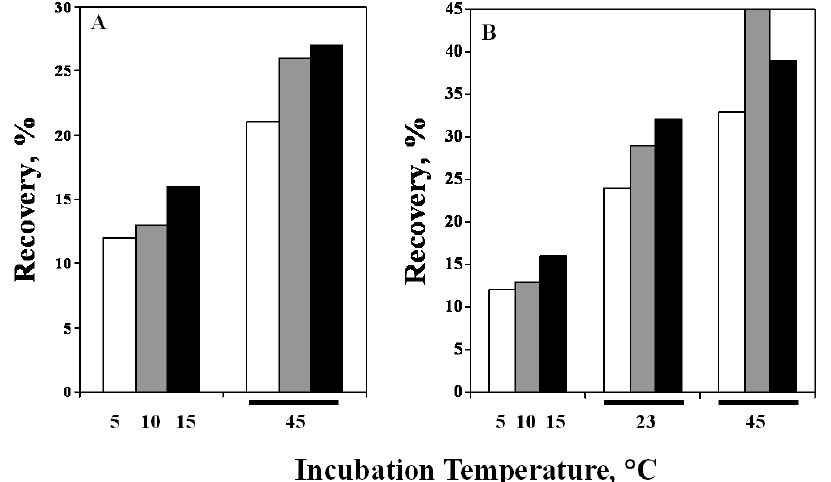
Figure 10. Effect of incubation temperature on refolding of scFv. Initial incubation temperature: white bar, 5 °C; gray bar, 10 °C; black bar, 15